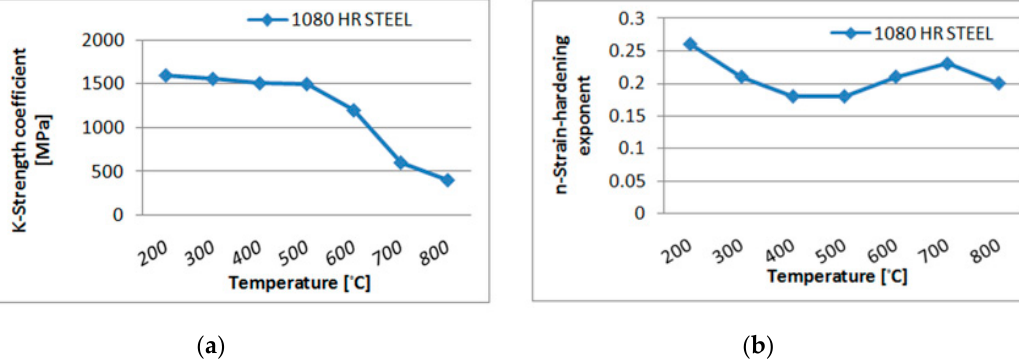
Figure 4. 1080 HR steel characteristics ( a ) K at different temperatures; ( b ) n at different temperatures.